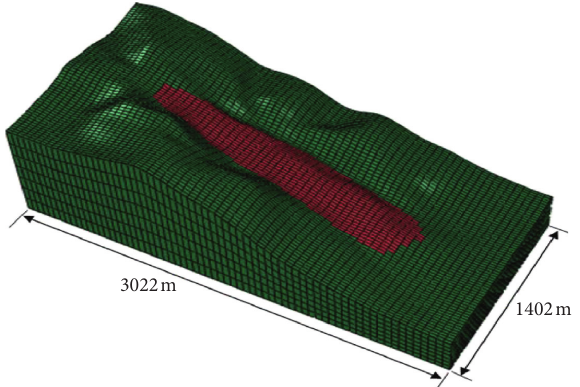
Figure 4: The model computing grid.